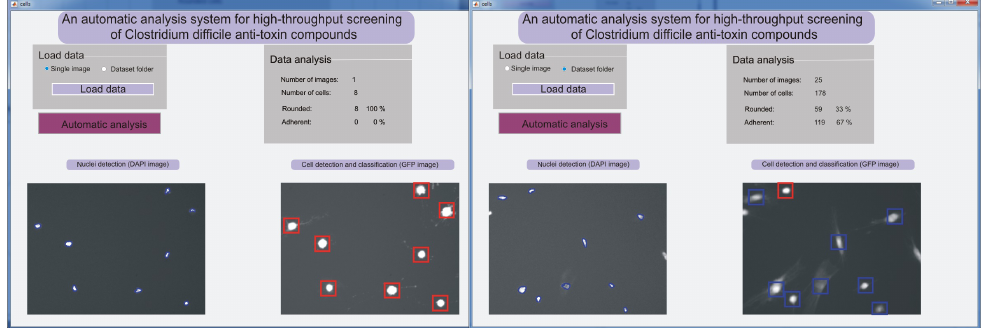
Figure 11. MATLAB graphical user interface (GUI) of the attached software for image selection, data processing, and statistical